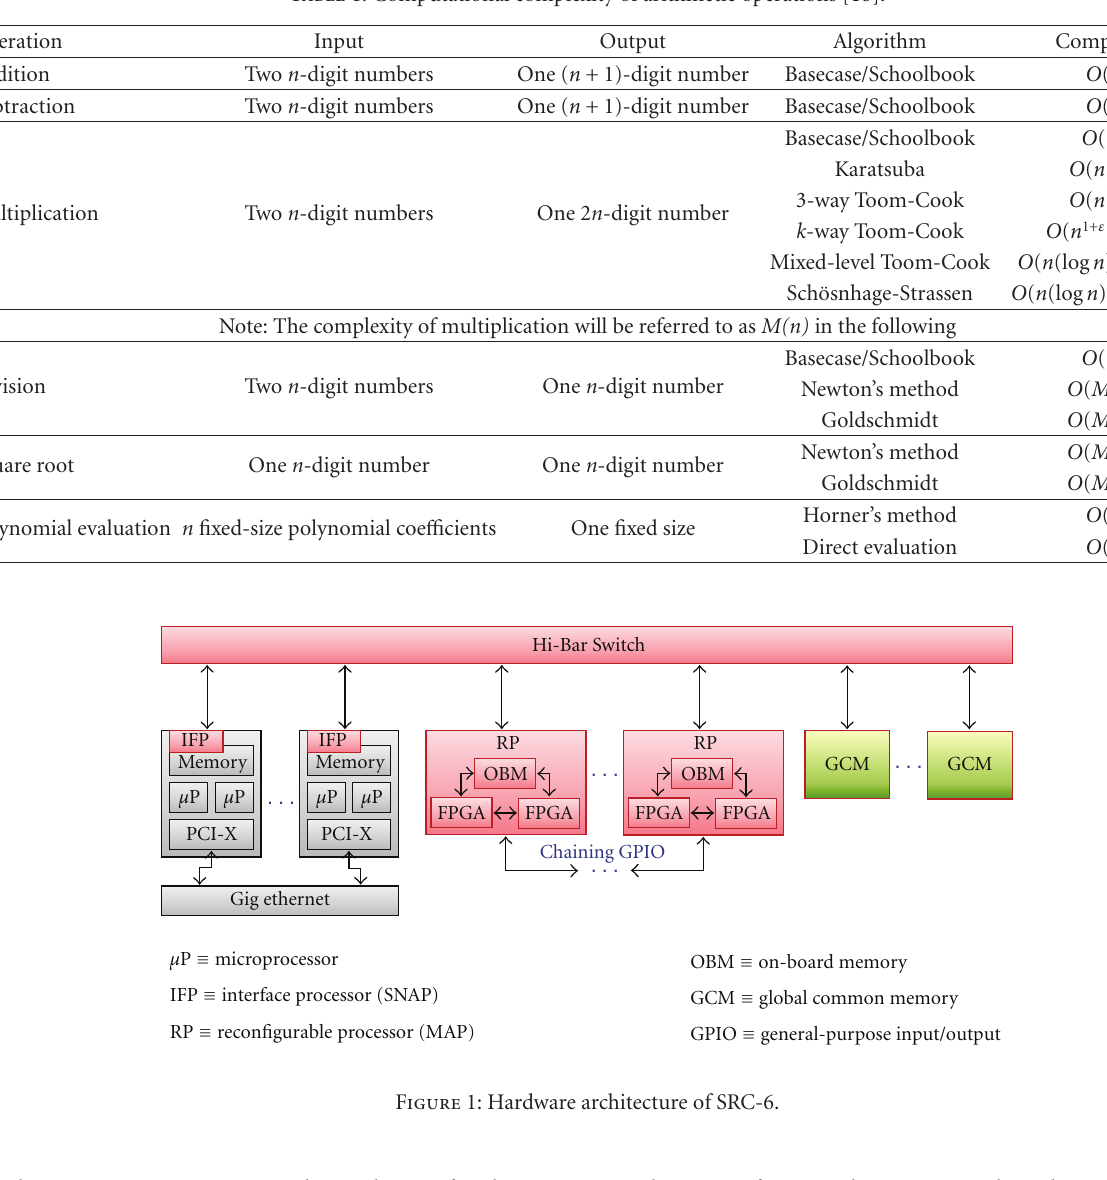
Table 1: Computational complexity of arithmetic operations [18].